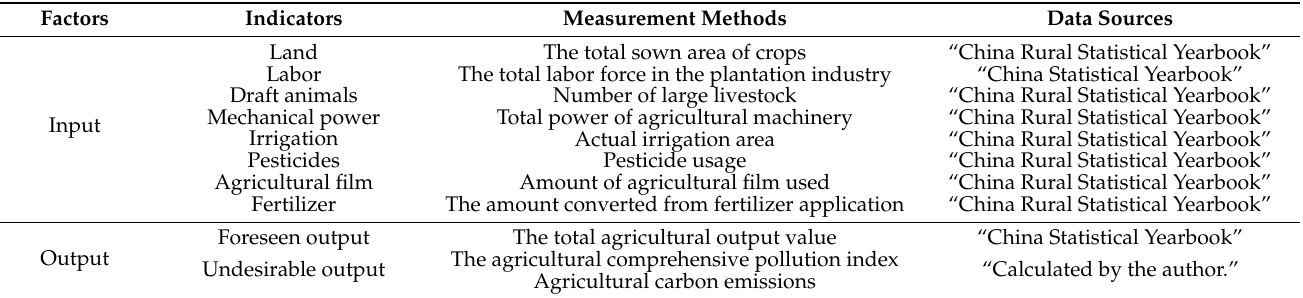
Table 1. Specific measurement indicators of